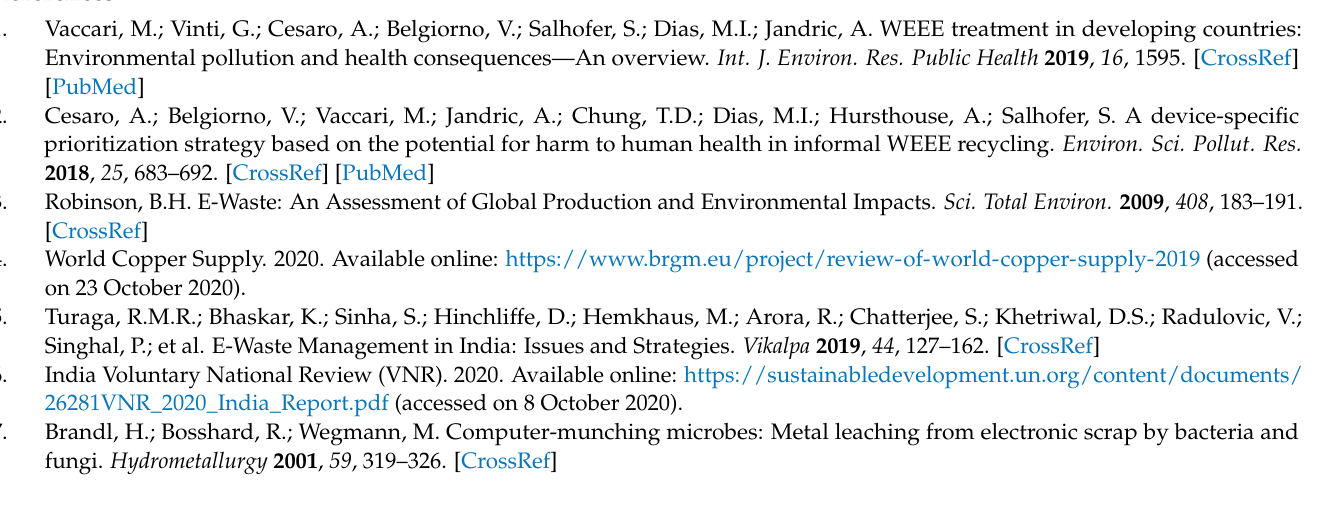
Figure S2: Diffusion controlled model for leaching of metals at various temperatures during bacterial and fungal leaching of PCB, pH 2.0 at 8% pulp density in the temperature range 298-313K